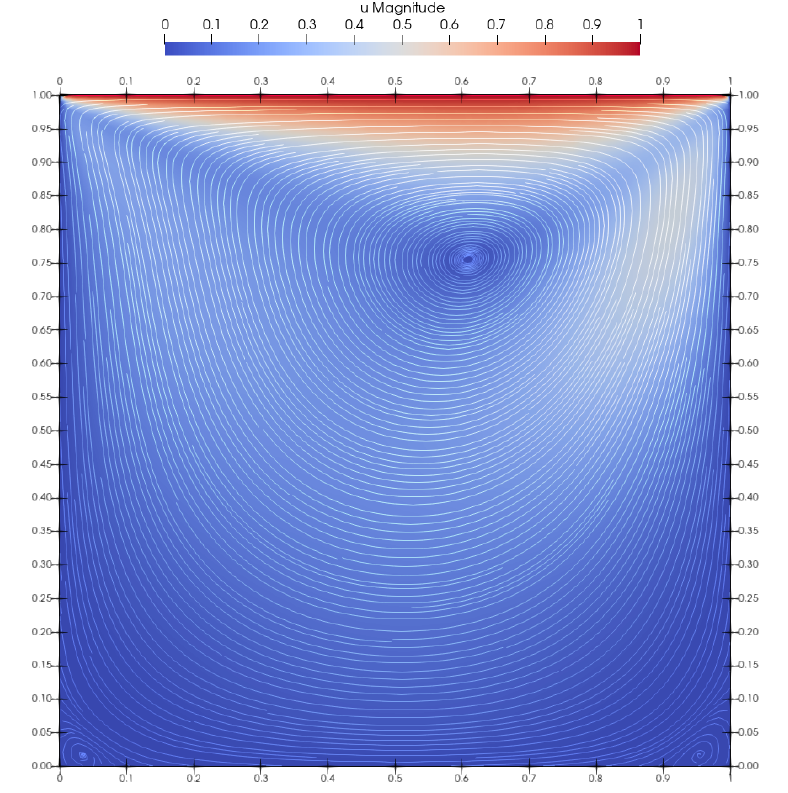
Figure 3. Plotted streamlines for Casson fluid flow at Re = 100 and Bn = 0.01.